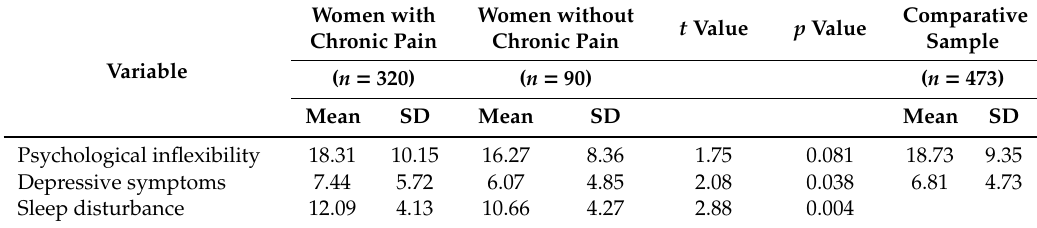
Table 2. Means and standard deviations of psychological inflexibility, depressive symptoms, and sleep disturbance scores in our study and in comparative samples.